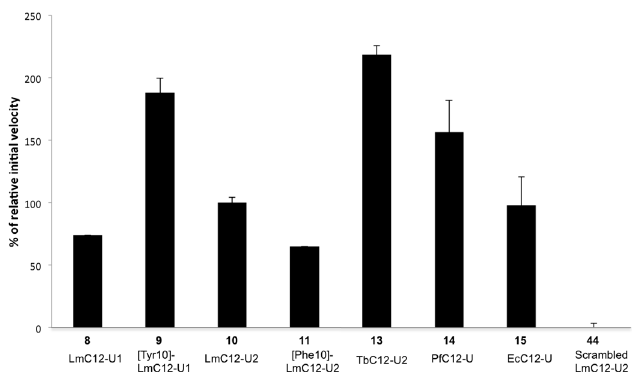
Figure 3. Both peptides derived from the C-terminal end of either LmHslU1 or LmHslU2 and analogues from other microorganisms are able to support LmHslV activation. LmHslV (75,2nM) was incubated at 37 ◦ C with the peptide substrate Z-EVNL-AMC (100 µ M) in the presence of peptides 8 – 11 and 1–15 (500 µ M). A scrambled version of LmC12-U2 ( 44 ) was also included. The fluorescence of the free AMC group, proportional to the activity of the sample, was measured at 2 min. intervals. The values are normalized by the initial velocity observed with the reference peptide 10 , LmC12-U2, set to 100%.